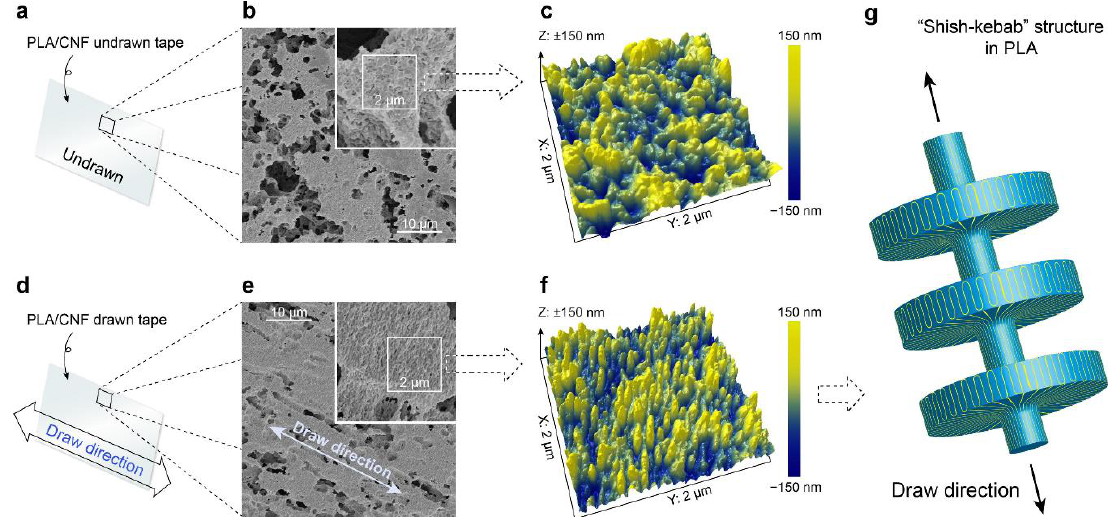
Figure 7. ( a ) Schematic representation of undrawn tape and ( b , c ) SEM and AFM images of undrawn tape respectively after etching; and ( d ) schematic representation of tape indicating drawing direction and ( e , f ) SEM and AFM of drawn oriented tape respectively after etching; and ( g ) Penning’s model representing “shish-kebab” structure. Reprinted with permission from [88].